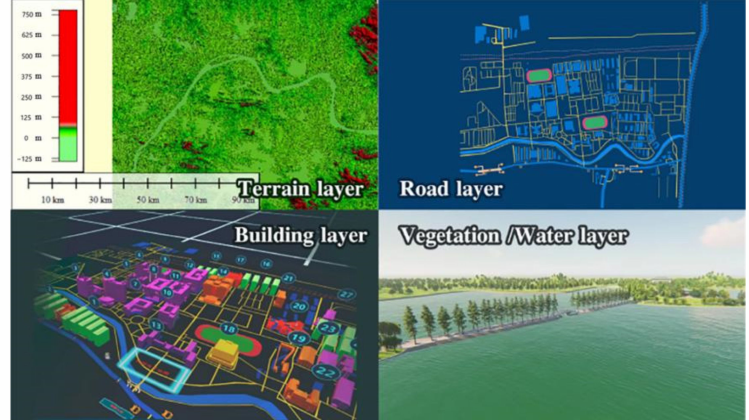
Figure 5. Scene layers of the campus.